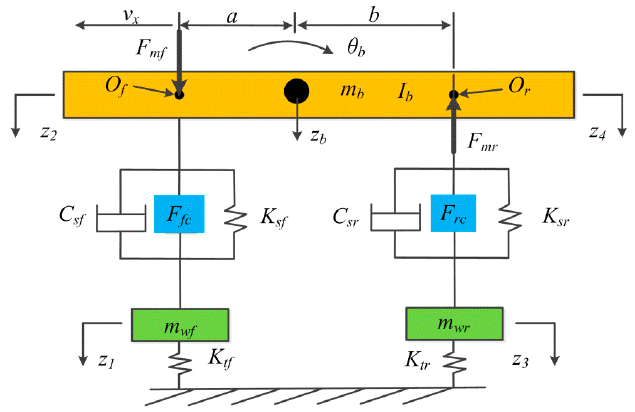
Figure 1. Equivalent half-vehicle model.